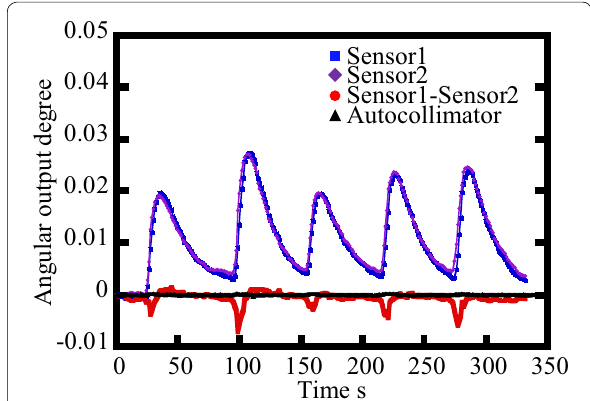
Figure 11 Variations of sensor outputs due to external disturbance